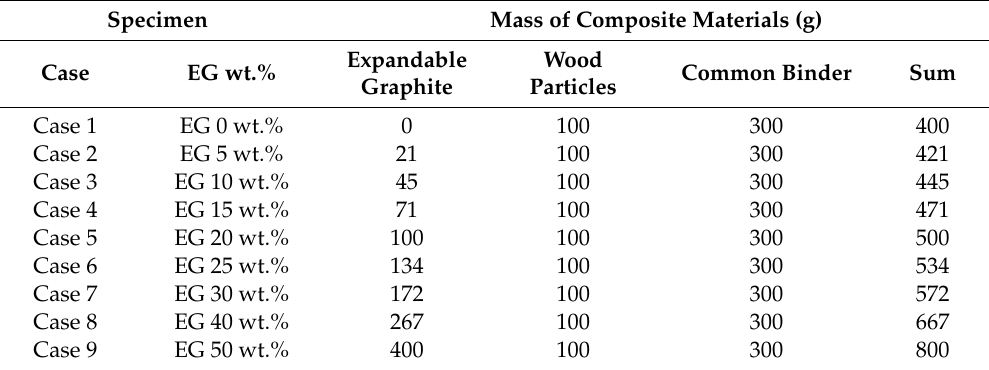
Table 2. Compositions of the expandable graphite composite materials.